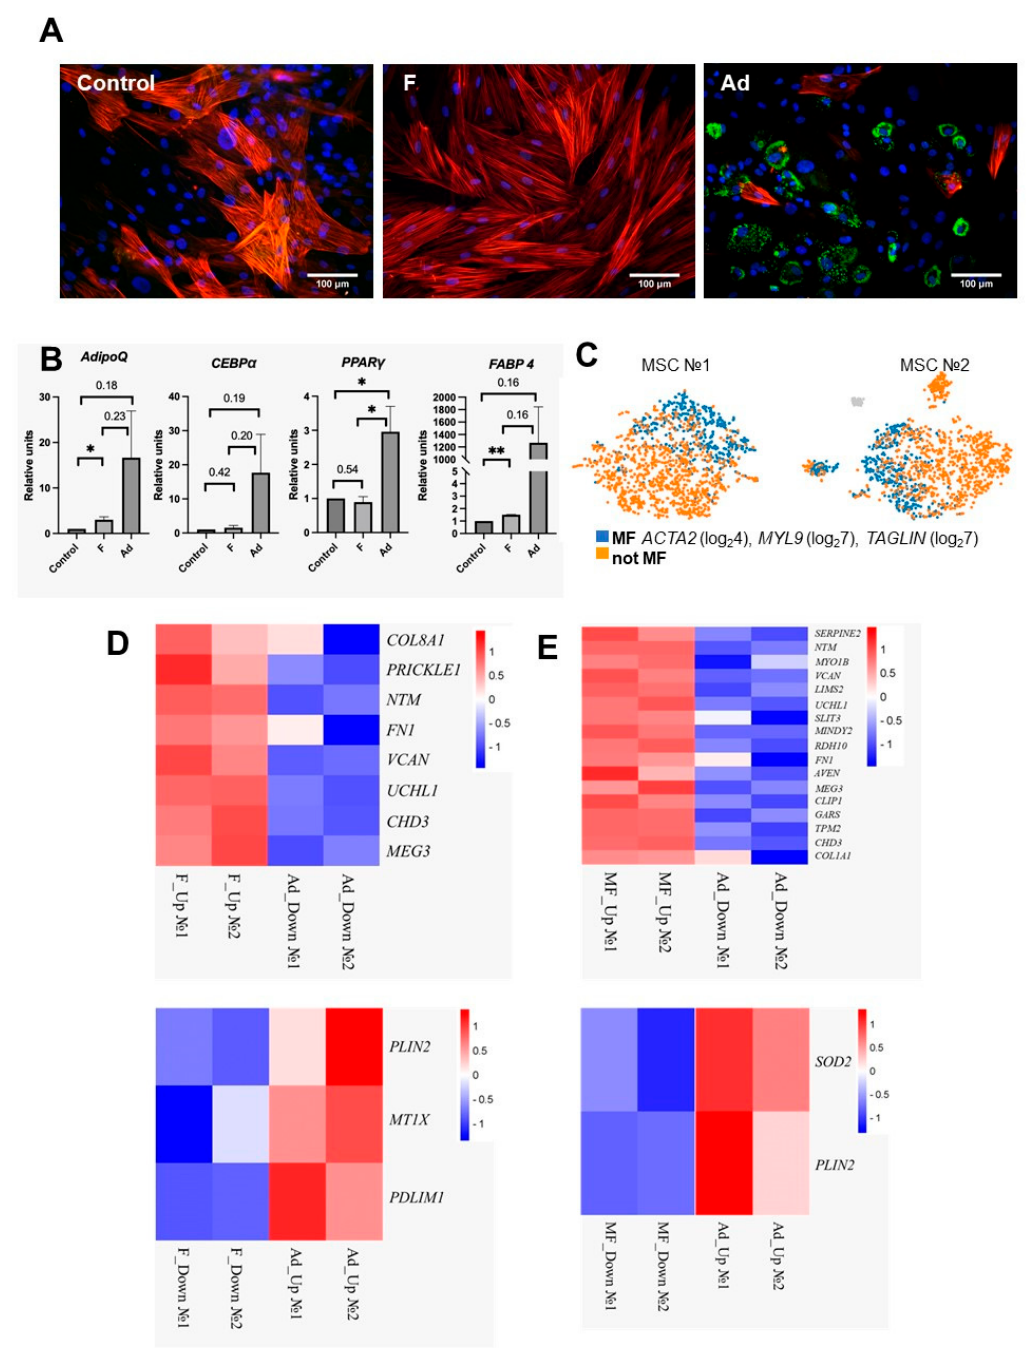
Figure 2. ( A ) Expression of α SMA (red) and perilipin (green) in cultured human MSCs after 4 days of TGF β -1 stimulation (F) or the induction of adipogenesis (Ad); nuclei are labeled with DAPI. ( B ) Analysis of changes in the expression of genes characteristic of adipogenesis in MSCs, mean ± SE, * p < 0.05, ** p < 0.01, with p > 0.05 p value is indicated. ( C ) Isolation of a cluster of myofibroblasts in the total analyzed population, MF—myofibroblasts. ( D ) Genes that change expression in MSCs in different directions after 4 days under profibrogenic conditions (F) or adipogenic (Ad) ( E ) Genes that change expression in different directions in MSCs after 4 days in profibrogenic conditions in an isolated cluster of myofibroblasts (MF) or adipogenic (Ad).